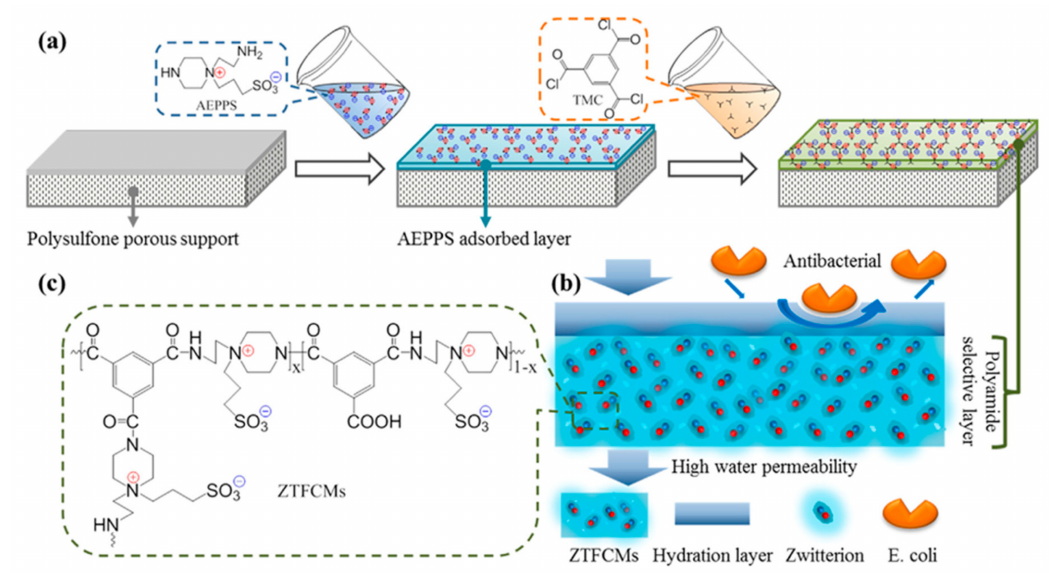
Figure 17. ( a ) Schematic diagram for preparing ZTFCMs. ( b ) Schematic model for water transport and antibacterial illustration of ZTFCMs. ( c ) Chemical structure of ZTFCMs. Reproduced with permission from Reference